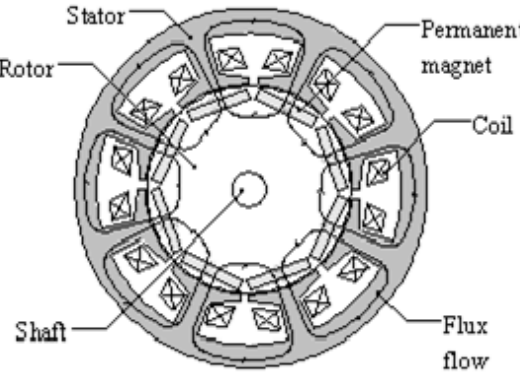
Figure 3. Structural features and flux flow of the portable electric generator